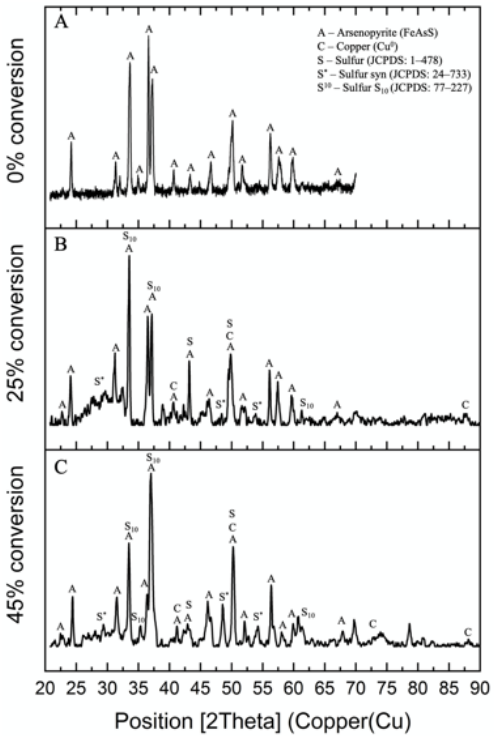
Figure 9. XRD pattern of FeAsS residue at different conversion degrees: ( A ) 0% conversion; ( B ) 25% conversion; ( C ) 45% conversion).